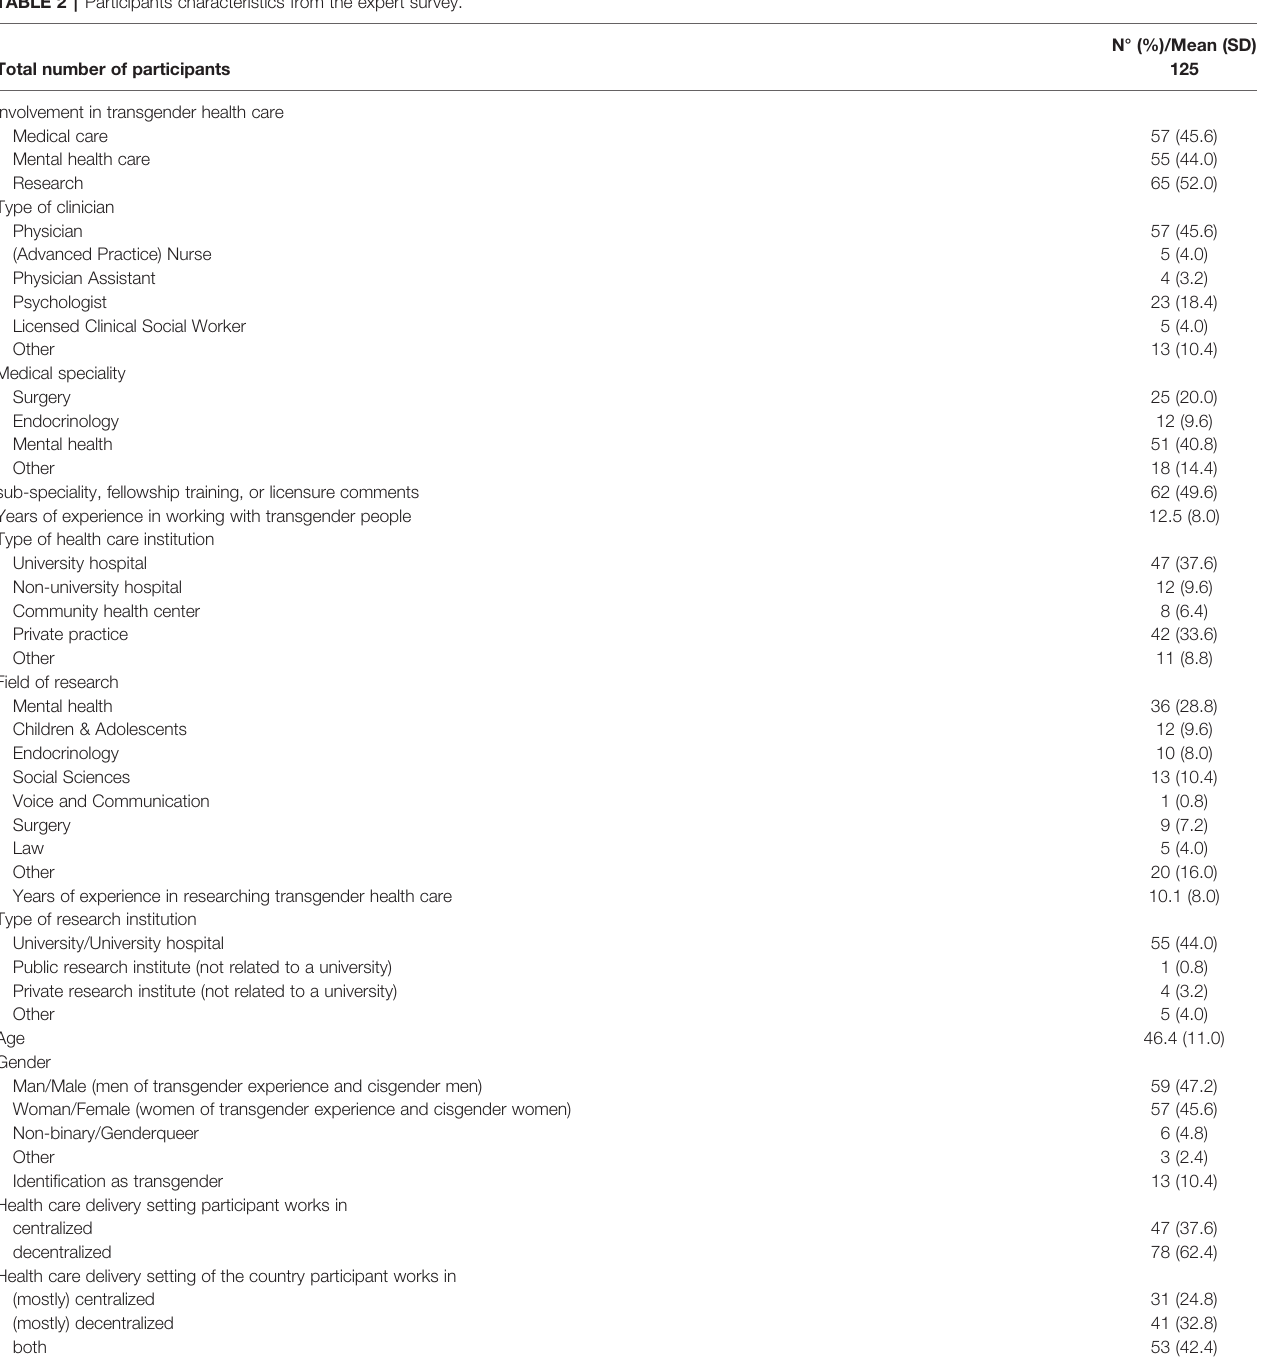
TABLE 2 | Participants characteristics from the expert